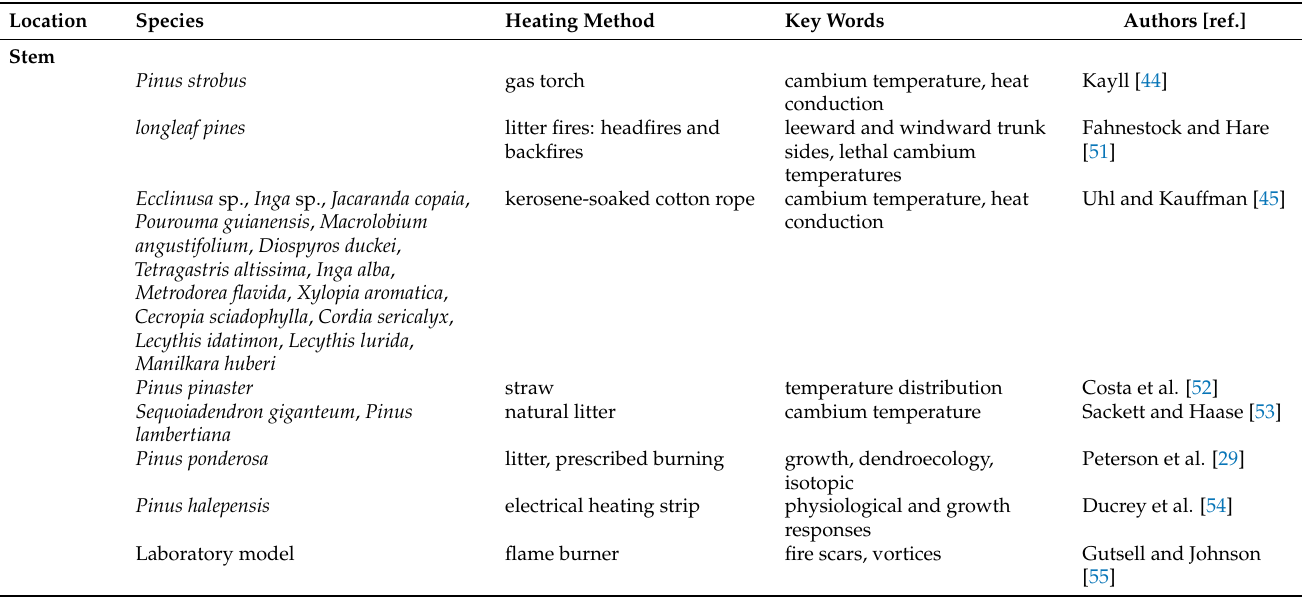
Table 1. Synthesis of experimental research on the effects of heat on the trunk and crown. Location Species Key Words Authors